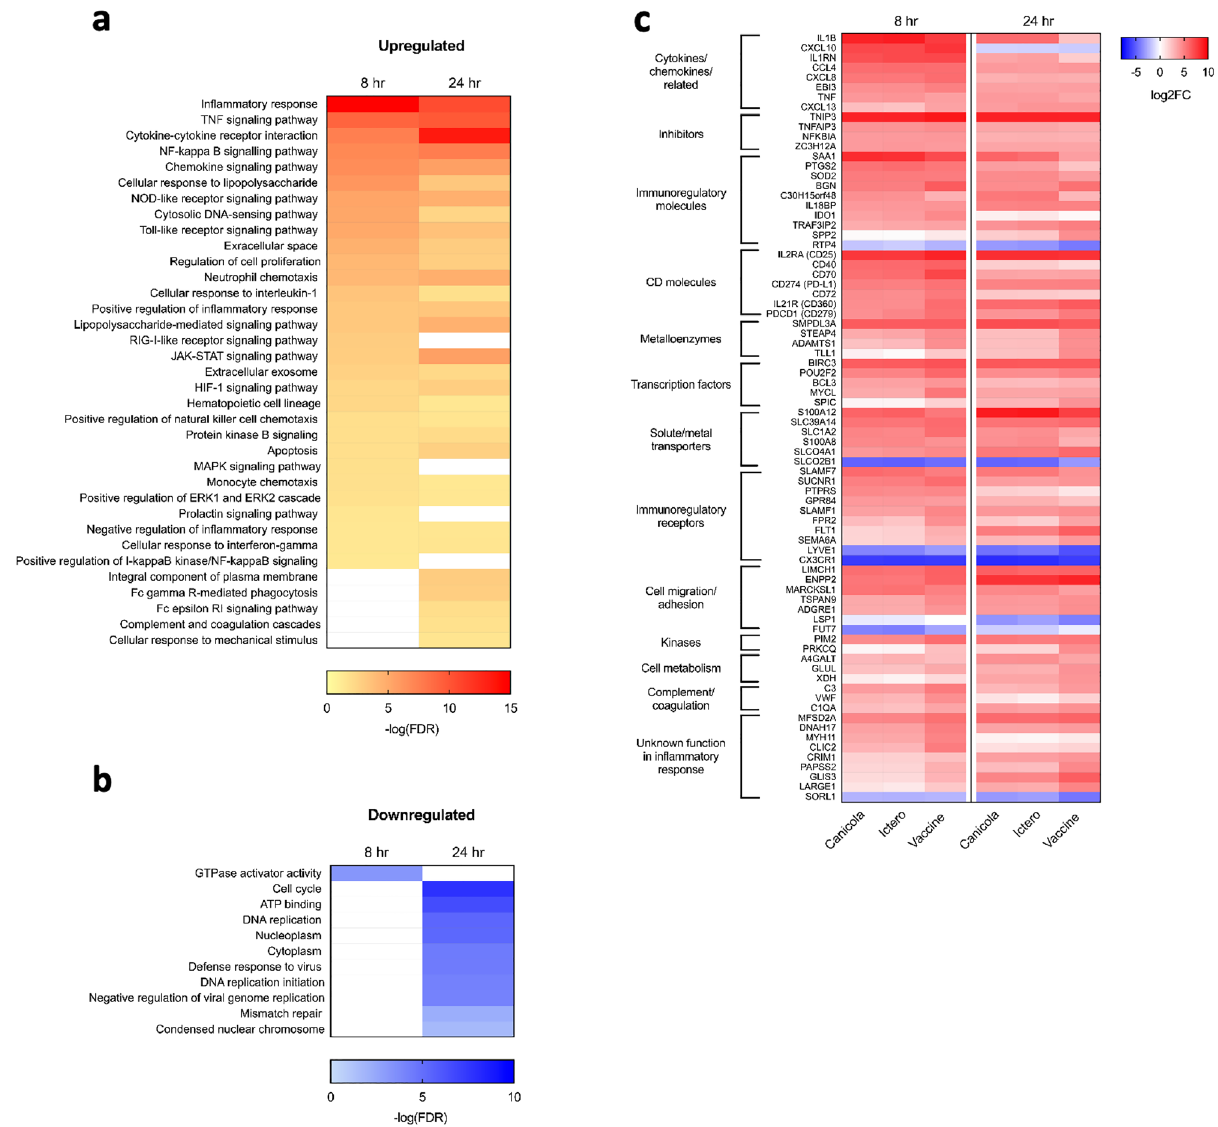
Figure 2. Common responses to the inactivated L. interrogans serogroup Canicola or Icterohaemorrhagiae and bivalent Leptospira vaccine B after 8 and 24 h stimulation. Pathways enriched for ( a ) upregulated and ( b ) downregulated genes found in common to stimulation with the inactivated L. interrogans serogroup Canicola or Icterohaemorrhagiae and bivalent Leptospira vaccine containing the same Leptospira strains from manufacturer B shown in Fig. 1b (FC ≥ 2; P < 0.001, FDR 5%). 752 and 918 common DEGs found at 8 and 24 h stimulation were included in pathway analysis. Blank spaces indicate non-significant or undetected pathways. ( c ) Among 752 and 918 DEGs that were found in common to all three stimuli at 8 and 24 h stimulation, respectively, 78 DEGs reached FC ≥ 16 in at least one of the conditions compared to the unstimulated control and were therefore considered as highly expressed. Heatmap shows these highly expressed genes grouped by function. The color key represents the changes from most downregulated (dark blue) to most upregulated genes (red). Each row is a gene, and each column is a stimulus (average of n = 3